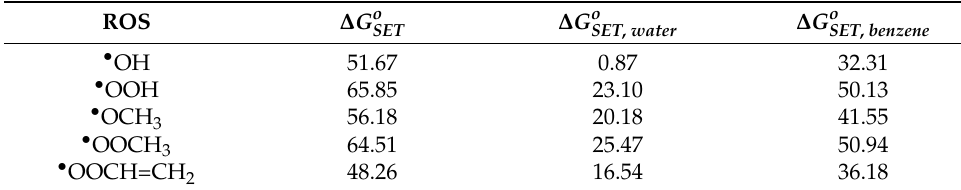
kcal mol − 1 ) computed in gas phase, water and SET